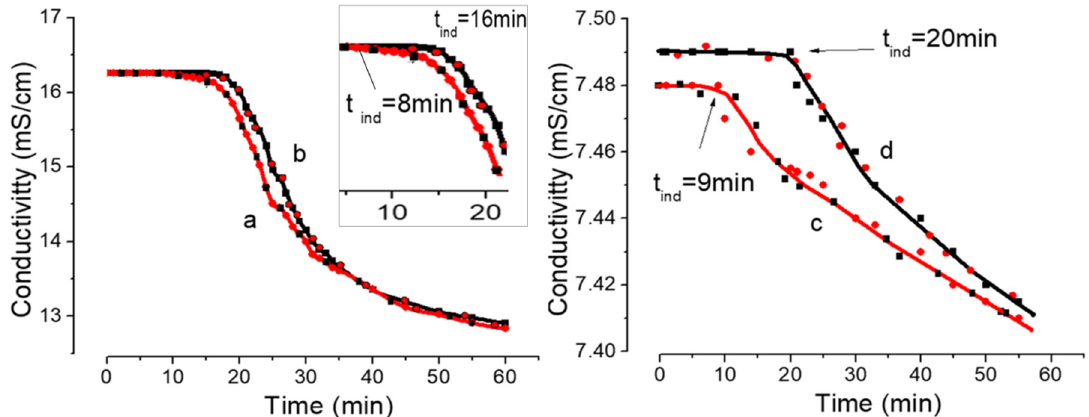
Figure 5. Dependence of conductivity on time for 0.05 ( left ) and 0.03 ( right ) mol · L − 1 gypsum supersaturated aqueous solutions at 25 ◦ C, prepared from nonfiltered ( a , c ) and filtered ( b , d ) stock brines (squares and circles correspond to different replicate measurements).